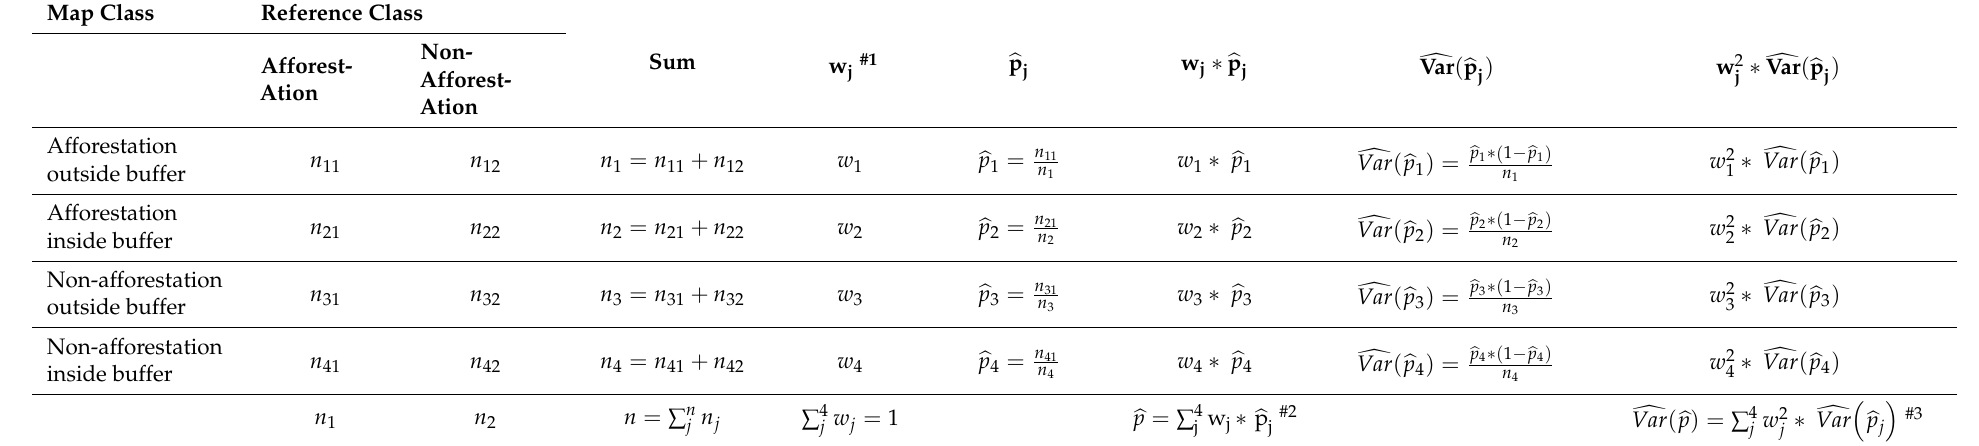
Table 1. Stratified estimator, confusion matrix to area estimates and CI